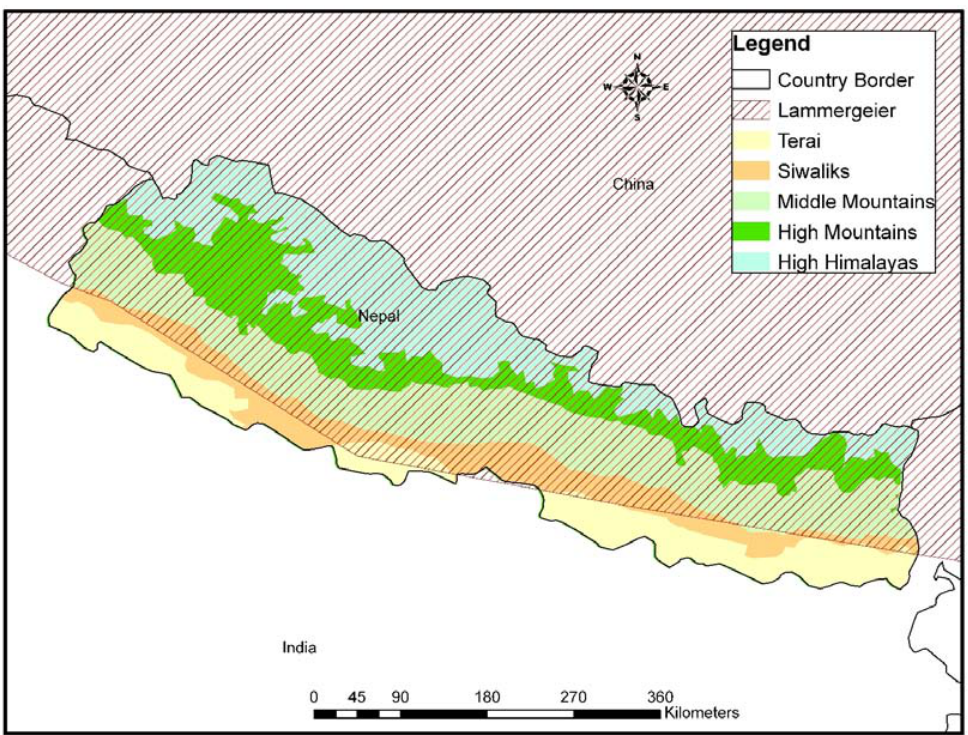
Figure 10. lammergeier Vulture distribution in Nepal. Adapted from (Birdlife International & NatureServe